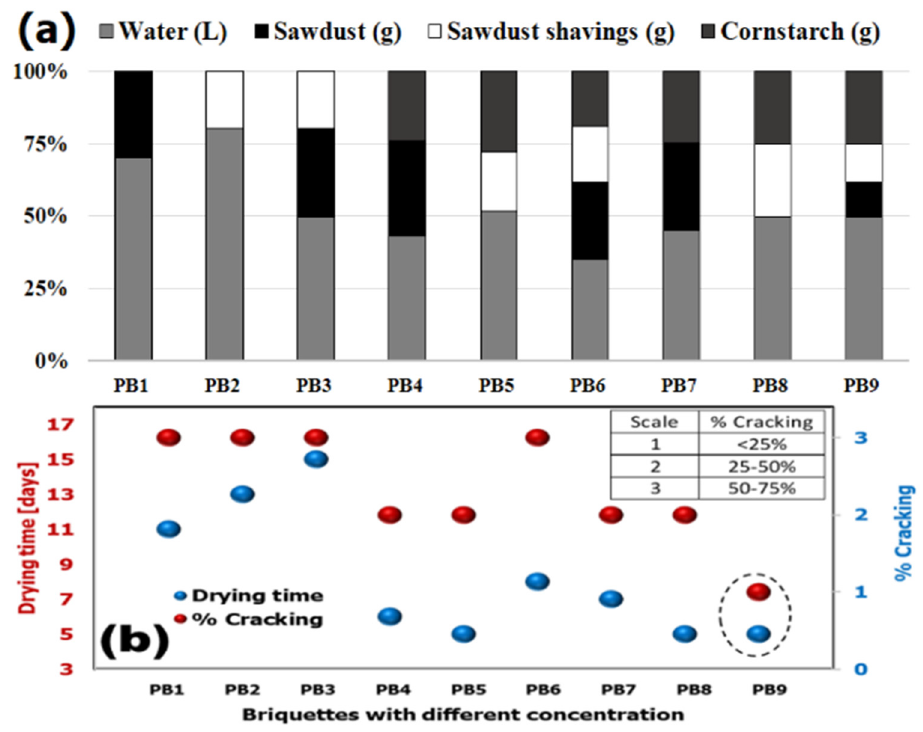
Figure 3. ( a ) formula for briquette production; ( b ) evaluation of drying time and percentage of cracking.